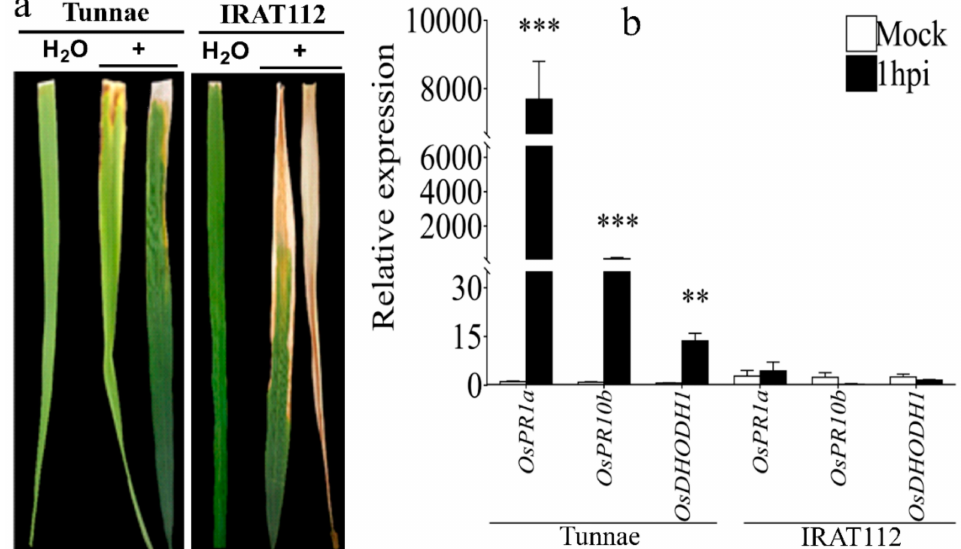
Figure 2. Phenotype at 21 days post inoculation (dpi) and transcriptional response of OsDHODH1 1 h after Xoo K3 inoculation in di ff erent rice cultivars. ( a ) Transcriptional level of OsDHODH1 gene relative to the expression of the pathogen-related genes ( OsPR1a and OsPR10b ) under Xoo K3 infection in rice, and ( b ) phenotypes of the most tolerant cultivar Tunnae ( japonica ) and the highly susceptible cultivar IRAT112 ( indica ) at 21 dpi. Bars are means ± SD. *** p < 0.001, ** p < 0.01. Empty is